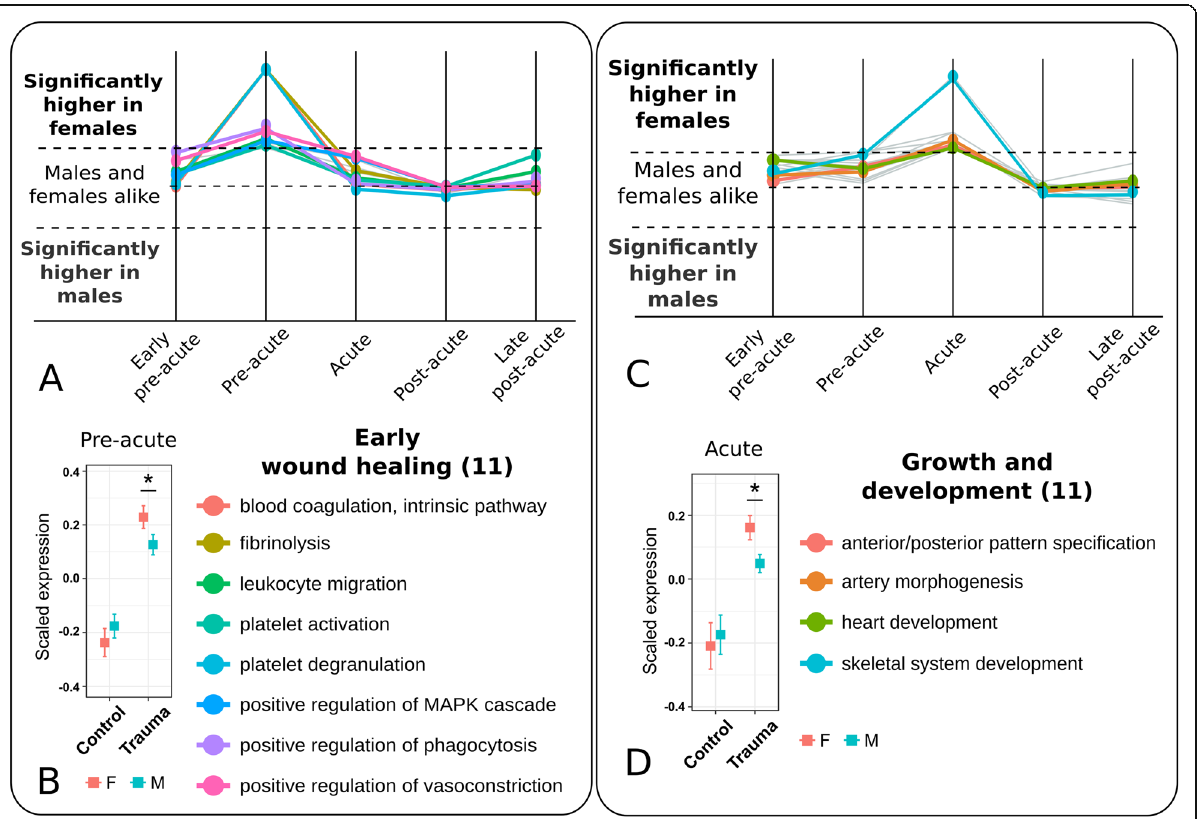
Fig. 3 Gene set clusters of the pre-acute (left) and acute phase (right). a The cluster of the pre-acute phase contained 11 gene sets being upregulated in leukocytes of female patients. These gene sets are all related to wound healing processes. Eight representative gene sets are shown here. The complete set is given in Additional file 1: Fig. S7. b In comparison to healthy controls, the gene sets were higher expressed in the leukocytes of both sexes. A distinctively higher expression was observed in the leukocytes of female patients. c The cluster of the acute phase contained 19 gene sets being upregulated in female patients. Eleven of these were associated with growth and development. Four representative gene sets are listed here. The complete list is given in Additional file 1: Fig. S8. d In comparison to healthy controls, leukocytes of both sexes showed a higher expression of these gene sets, distinctively higher expression was observed in leukocytes of female patients. The z-transformed expression values were referred to as ‘ scaled expression ’ values. Significance of difference between the expression of genes of male and female patients was tested using two-sided Student ’ s t-tests (* P <0.05, mean bar and Whiskers of the boxplots: